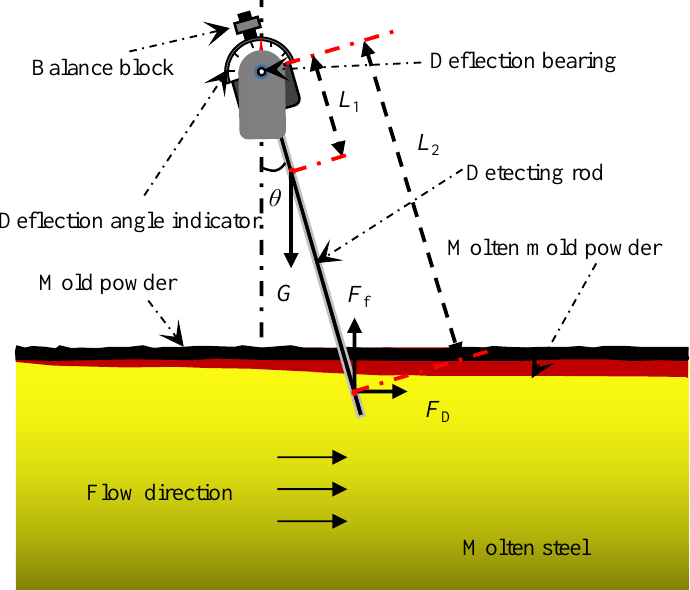
Figure 1. Schematic diagram of measuring velocity near the mold surface by rod deflection method.